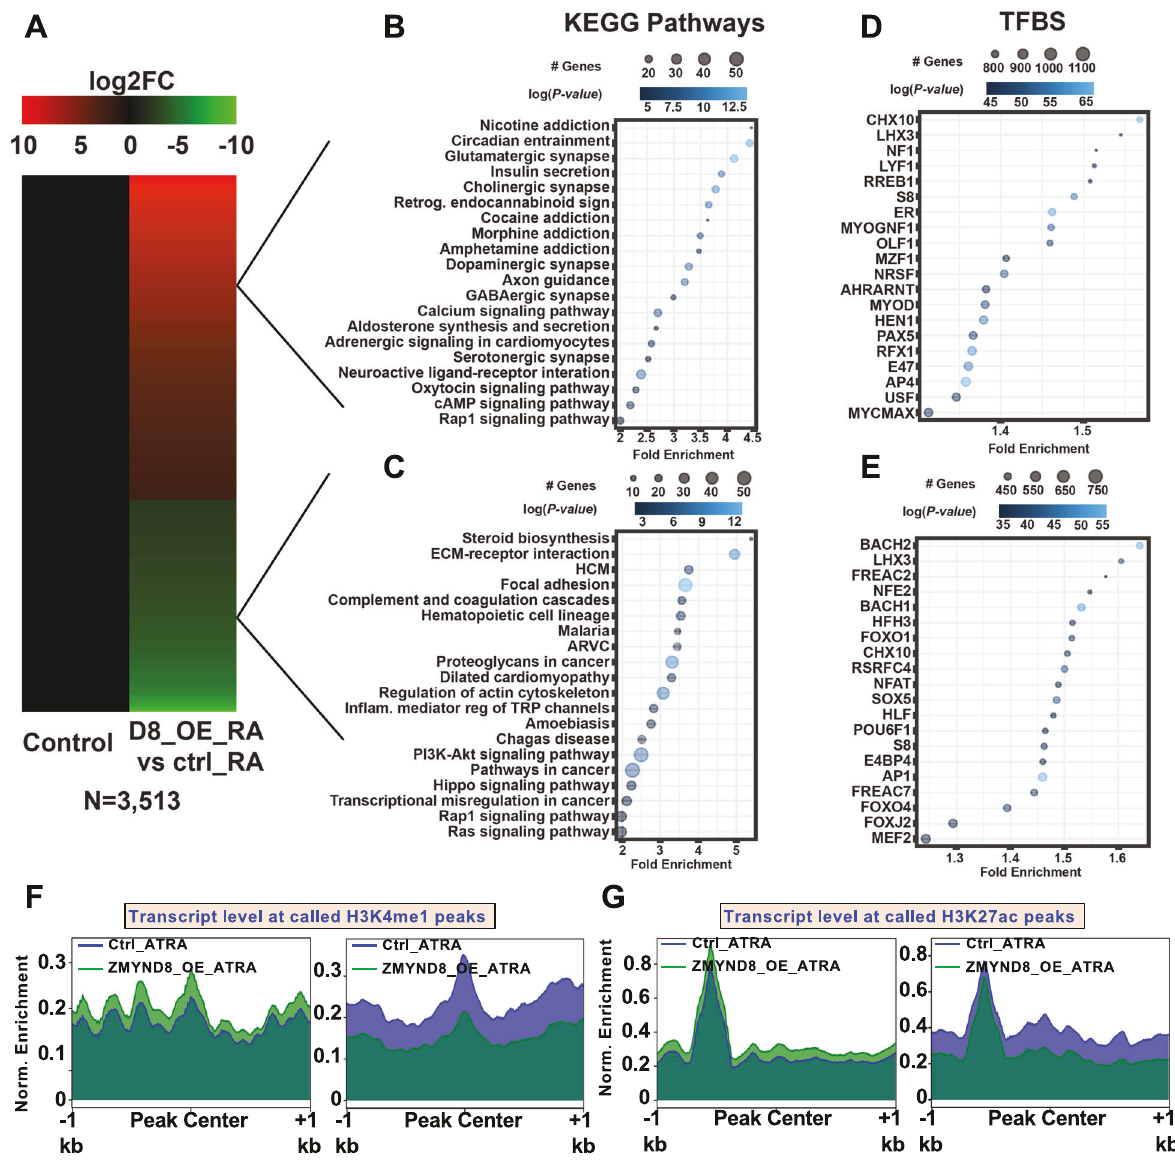
Fig. 2 ZMYND8 overexpression along with ATRA treatment triggers key pathways involved in neuronal differentiation. A Heatmap showing differential gene expression upon ZMYND8 overexpression with ATRA treatment (annotated as ZMYND8_OE_ATRA). B – E KEGG pathways ( B , C ) and TFBS ( D , E ) of up ( B , D ) and down ( C , E ) regulated genes. F , G Transcript levels quanti fi ed at enhancers upon ATRA treatment with or without ZMYND8. Enhancers were de fi ned by H3K4me1 and H3K27ac marks obtained from ENCODE ChIP-seq data in SK-N- SH